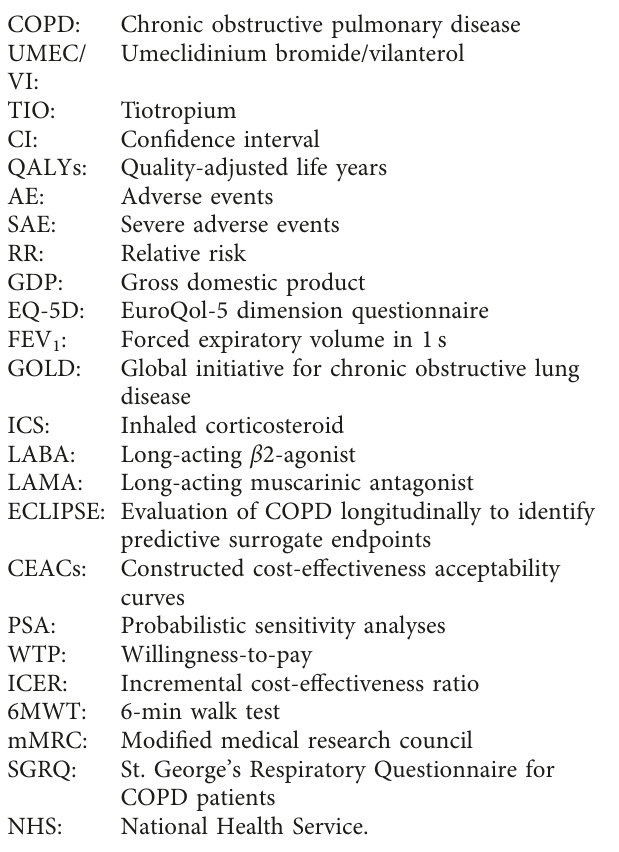
Supplementary Figure 1. The selection flow is summarized in Supplementary Figure 1. The basic characteristics of the included RCTs are summarized in Supplementary Table